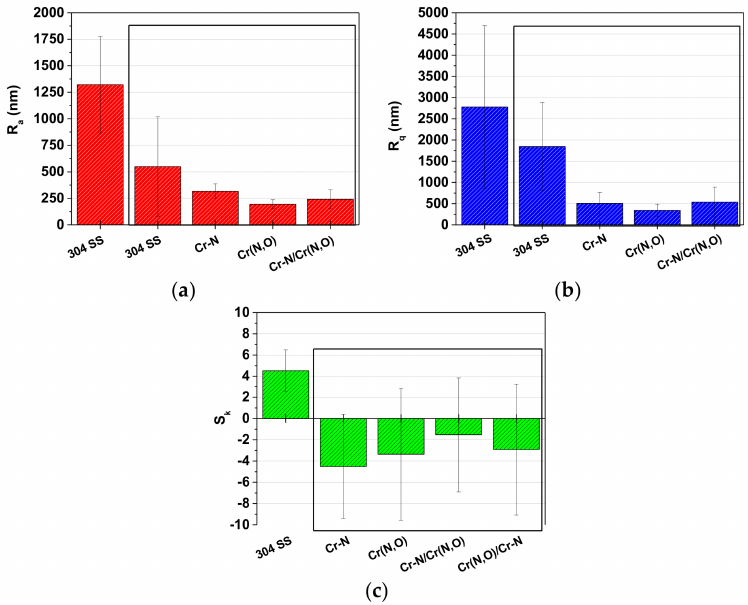
Figure 10. The roughness of Cr-based coatings after the corrosion test: ( a ) R a parameter; ( b ) R q parameter; ( c ) S k